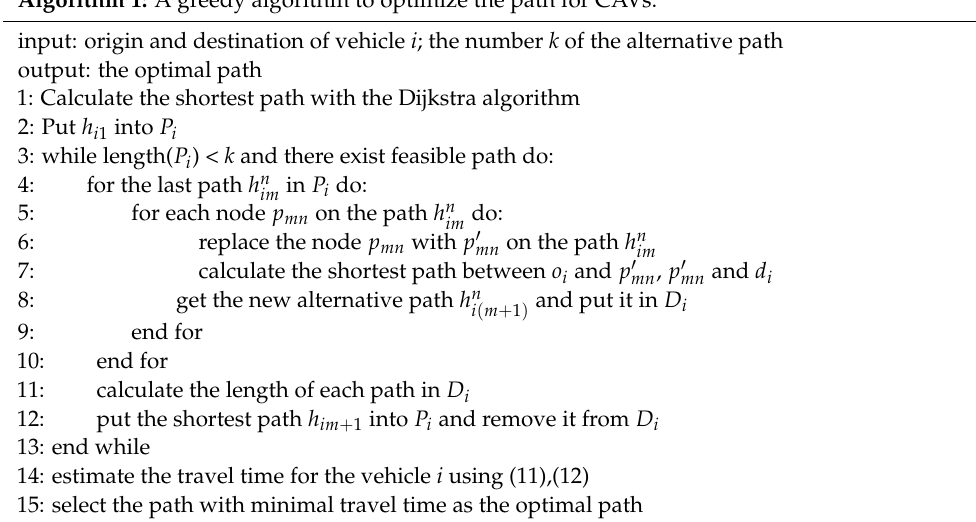
Algorithm 1: A greedy algorithm to optimize the path for